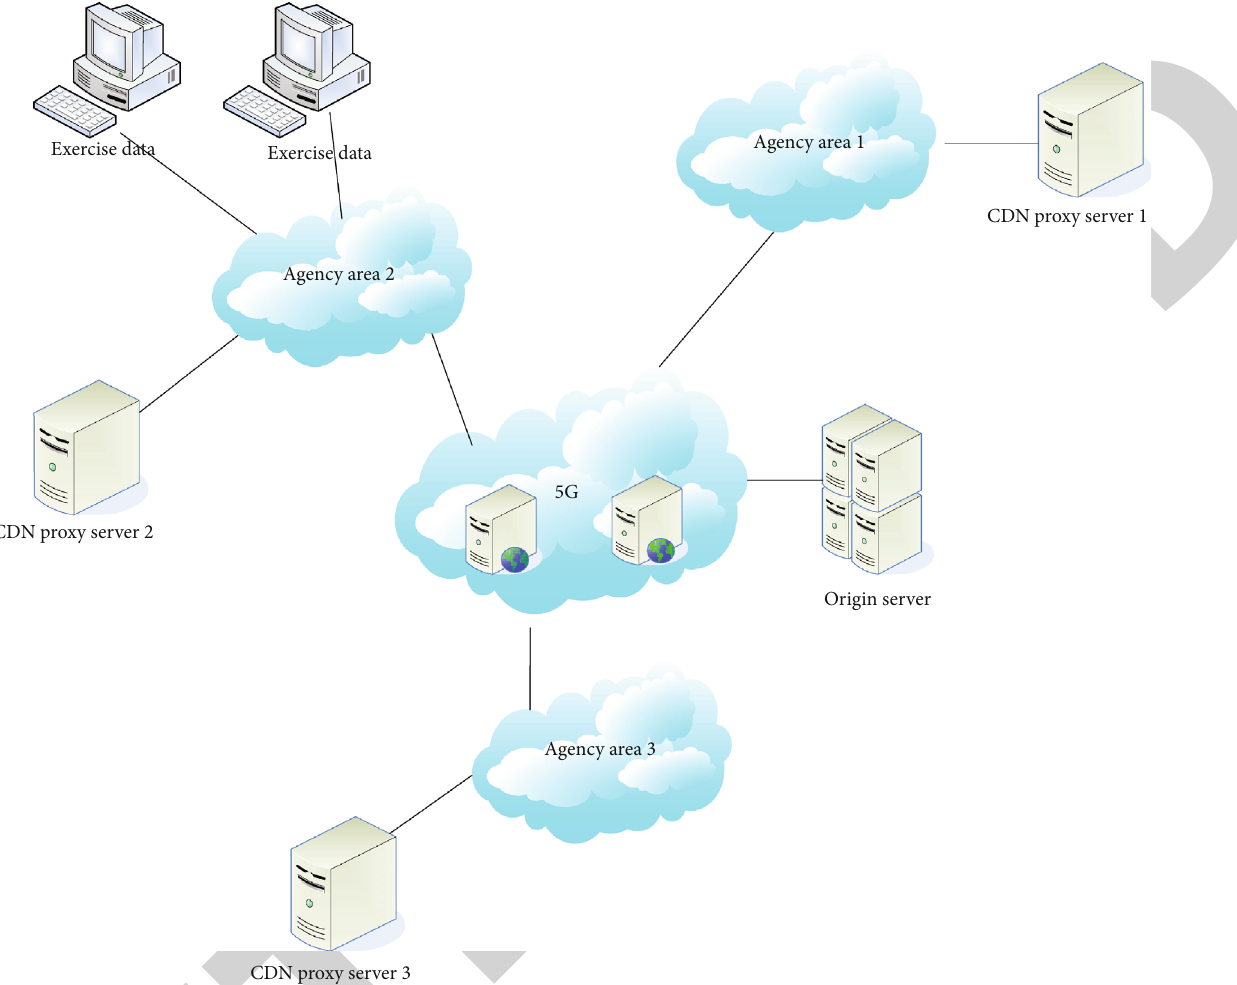
Figure 2: Processing of sports data under 5G